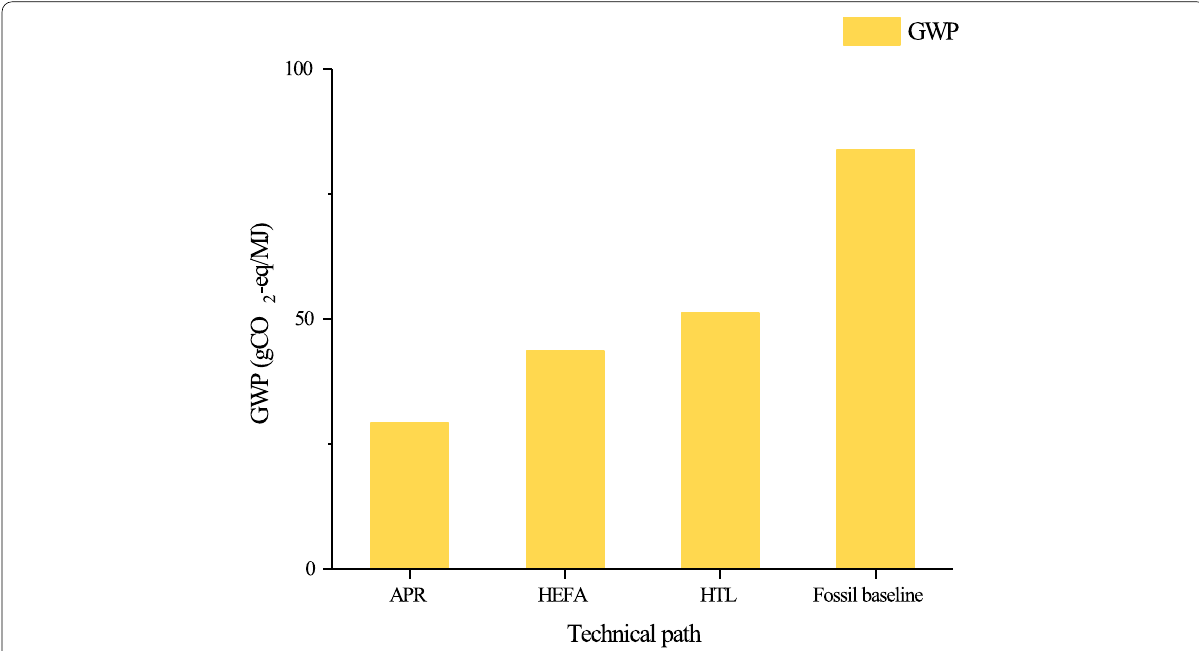
Fig. 5 Global warming potential of three technical